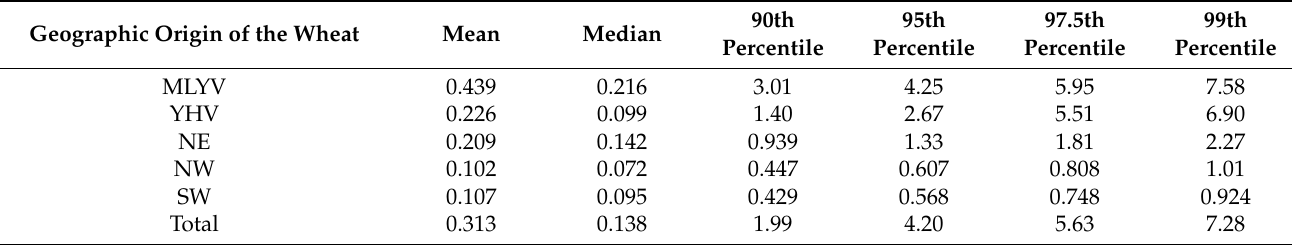
Table 5. The estimated dietary DON exposure through wheat-based products from different areas for adult men determined by point evaluation ( µ g/kg bw/day).